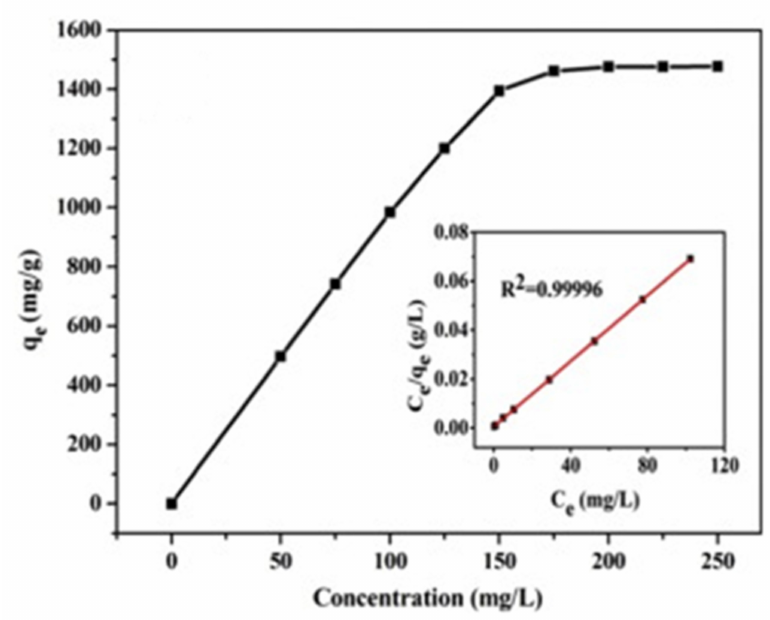
Figure 8. Langmuir fit for lead removal using Fe@MgO nanocomposites. Reproduced with permis- sion from